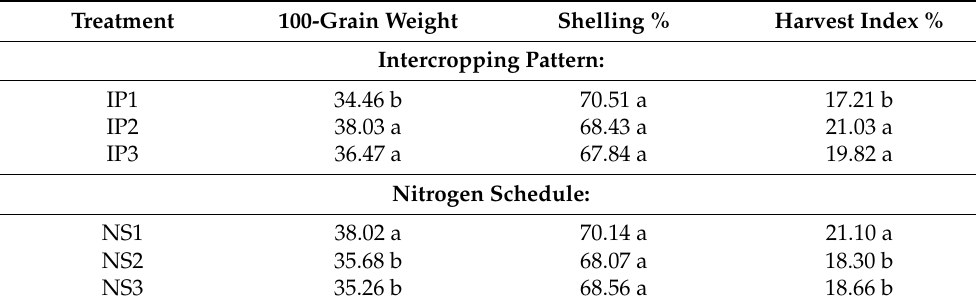
Table 4. Variations of the 100-grain weight (g), shelling % and harvest index (%) of maize crop as affected by the intercropping pattern and nitrogen schedule combined over the two growing